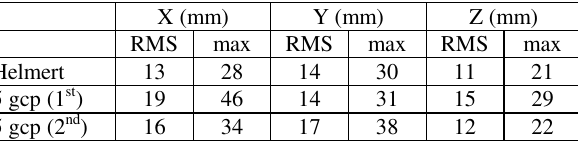
Table 6. Herzjesu, automatic orientation: statistics of the